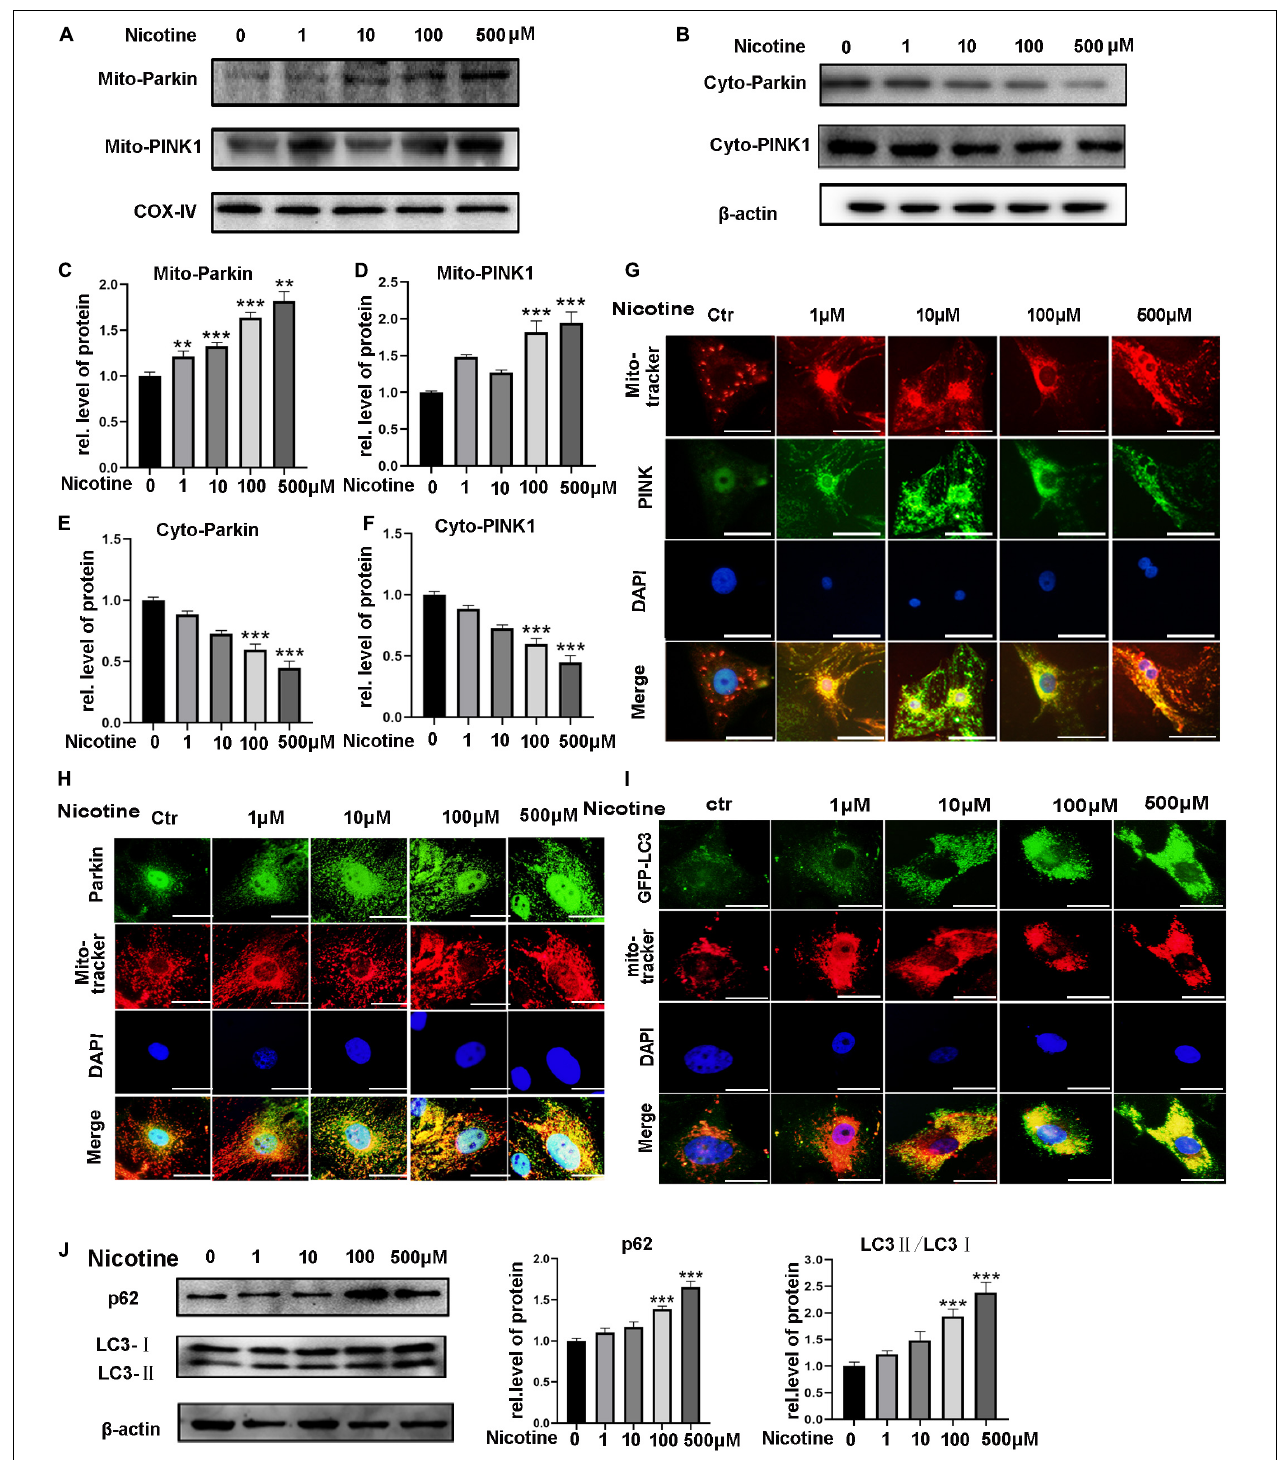
FIGURE 1 | Nicotine impaired mitophagic flux via PINK1/Parkin pathway. (A,B) PINK1 and Parkin expression levels were tested by western blotting in mitochondria and cytoplasm. (C–F) Image J was used to quantification (*** p < 0.001; ** p < 0.01, n = 3). (G,H) Immunofluorescence assay for the distribution of PINK1 and Parkin in cytoplasm and mitochondria (I). Co-localization of LC3 and mito-tracker was used to detect mitophagic flux with nicotine treatment for 24 h. Representative of n = 3 experiments. (Scale bar = 20 µ m) (J) Western blotting was used to explore the expression of p62 and LC3 with nicotine treatment for 48h.